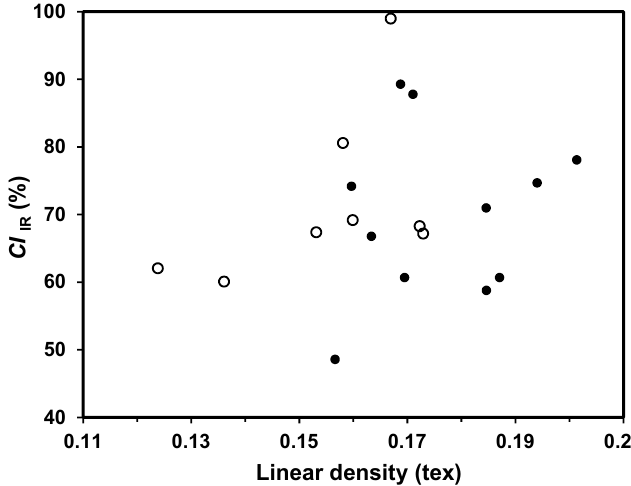
Figure 7. Plot of CI vs. linear density between fine ( ○ ) and coarse ( ● ) fibers. IR